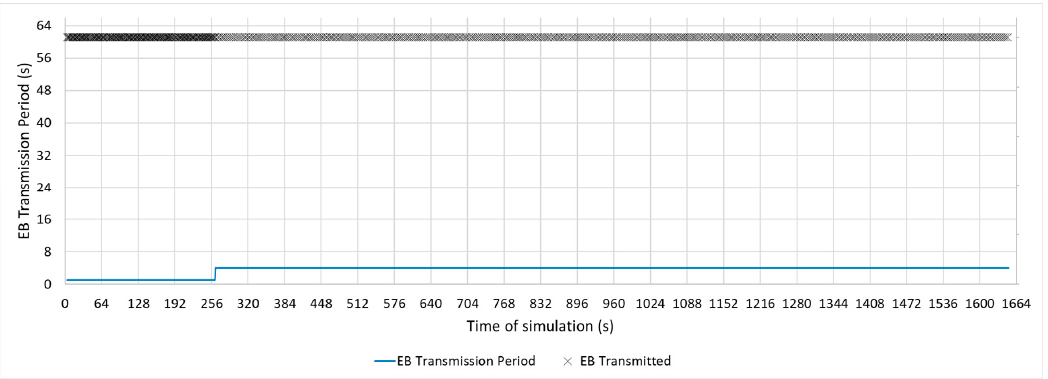
Figure 11. M4s Configuration.